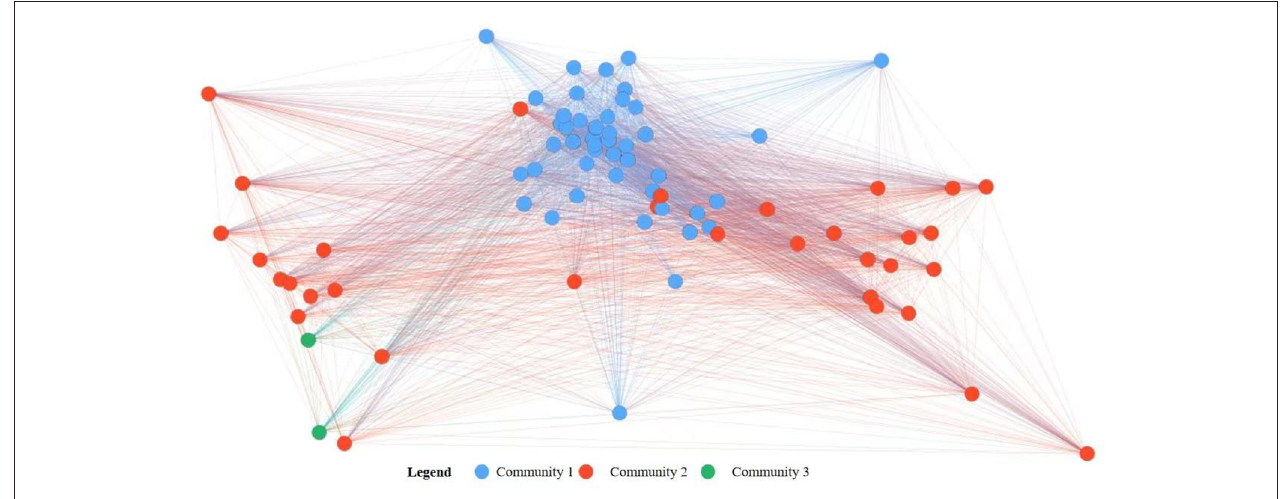
FIGURE 1 | Community detection in the global medical device trade network in 2020.